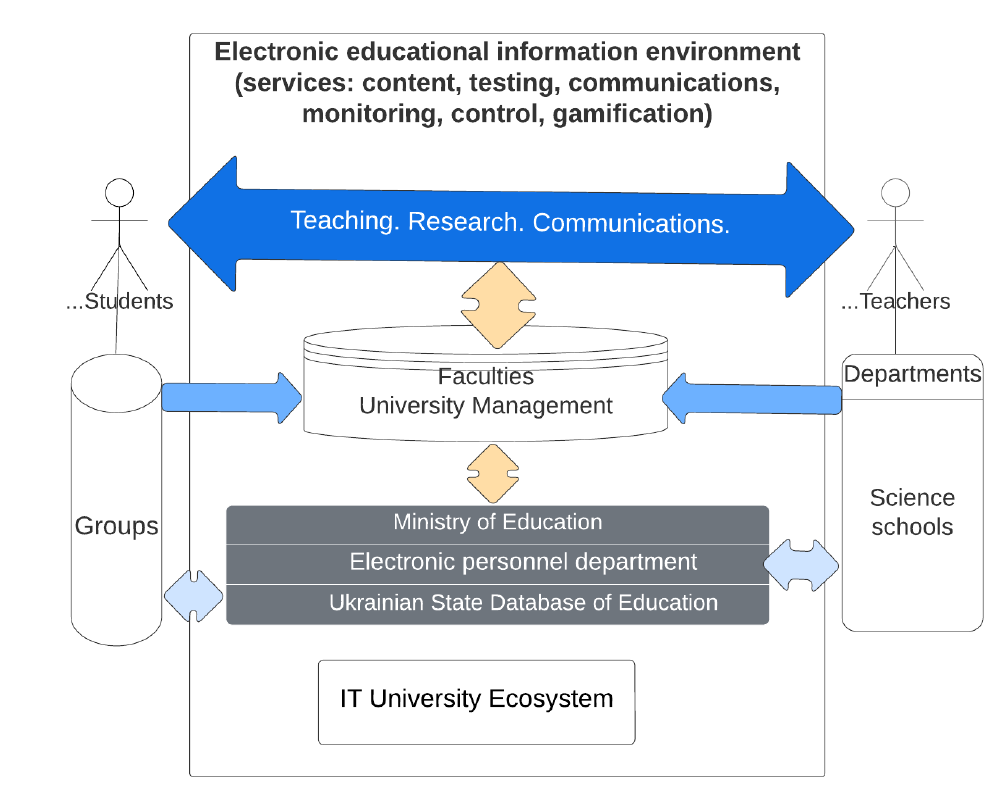
Figure 1. The structure of the JetIQ electronic ecosystem of